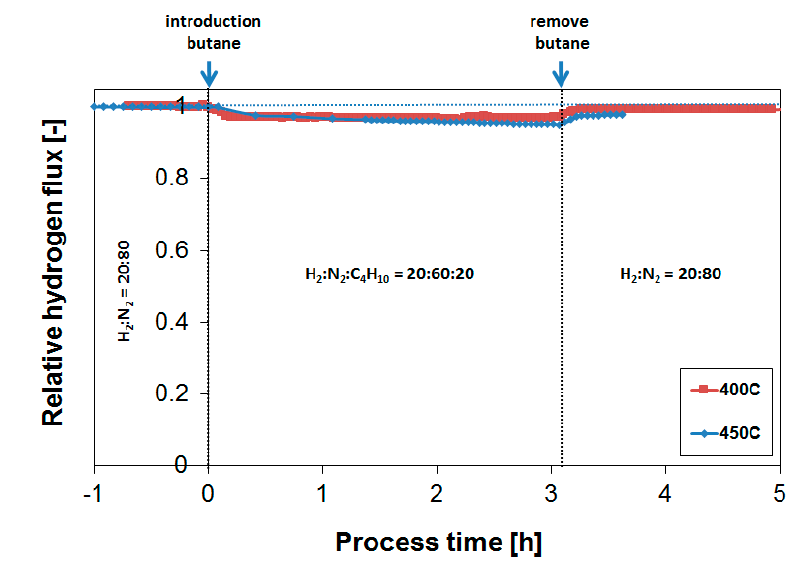
Figure 3. Effect of temperature on the obtained relative H 2 flux during butane exposure applying a feed mixture of H 2 :C 4 H 10 :N 2 = 20:20:60.